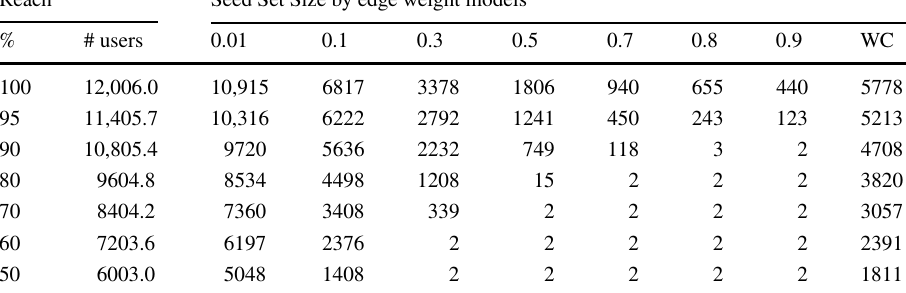
Reach Seed Set Size by edge weight